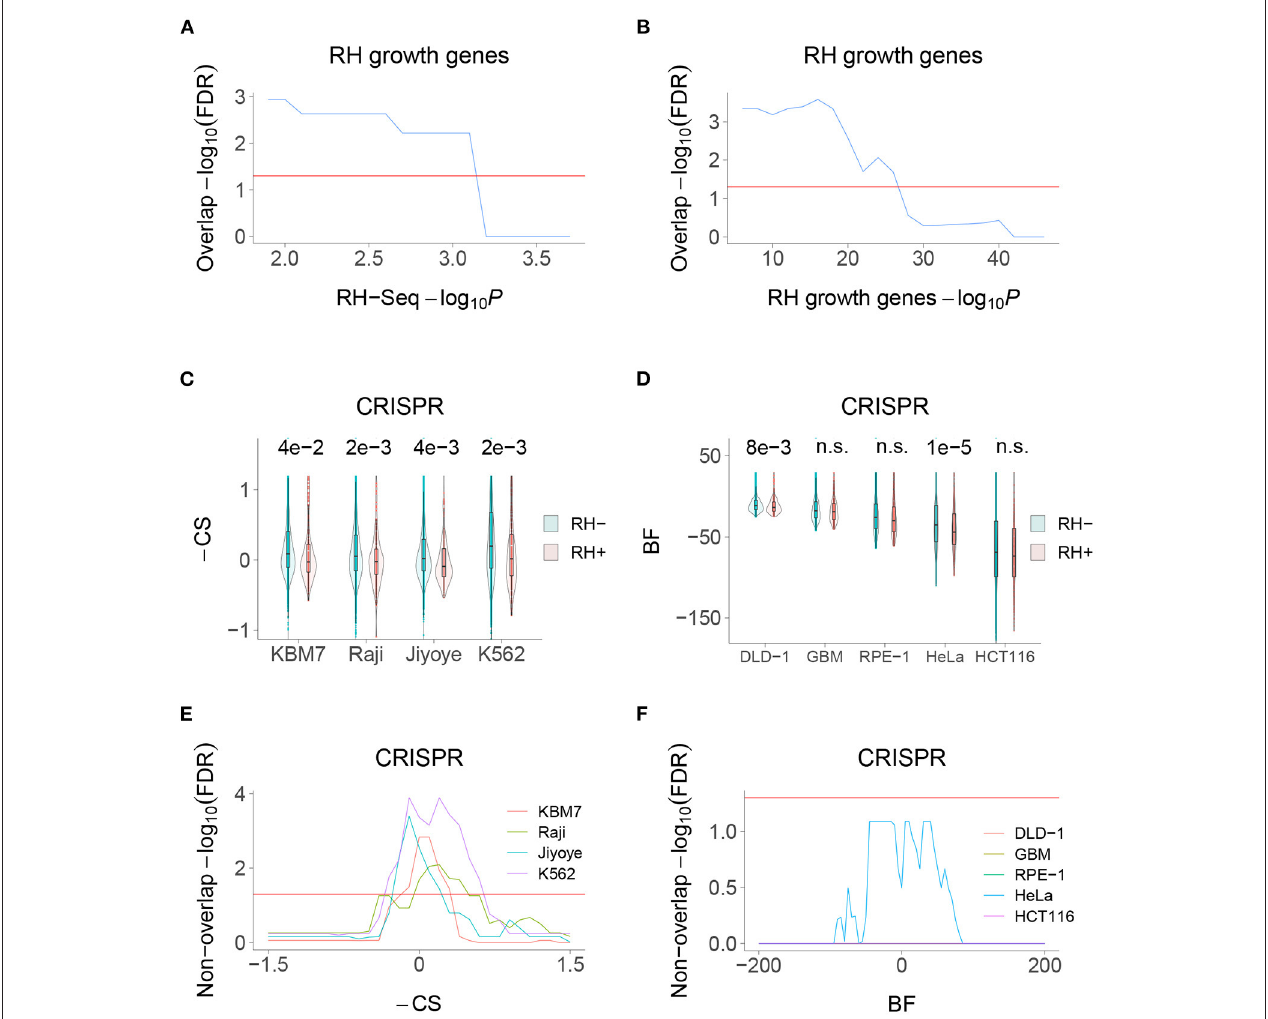
FIGURE 6 | RH-Seq network and growth genes. (A) Overlap of RH-Seq network and RH growth genes, thresholded on RH-Seq network − log 10 P . Overlap significance diminishes as threshold increases due to decreased numbers. (B) Overlap of RH-Seq network and RH growth genes, thresholded on RH growth gene − log 10 P . (C) RH-Seq interaction genes (RH+) show lower growth effects when inactivated using CRISPR than non-interaction genes (RH − ). Higher − CS values (CRISPR score times − 1) mean stronger growth effects of CRISPR null alleles ( Wang et al., 2015). P -values shown above comparisons. (D) RH-Seq interaction genes show lower growth effects when inactivated using CRISPR. Higher Bayes factors (BF) means stronger growth effect of CRISPR null alleles ( Hart et al., 2015). (E) Significant non-overlap of RH-Seq network genes and CRISPR growth genes, thresholded on − CS score. (F) Non-overlap of RH-Seq network genes and CRISPR growth genes, thresholded on BF score. Horizontal red lines, FDR =